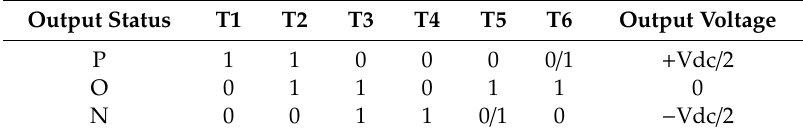
Table 1. Switching status of the proposed ANPC